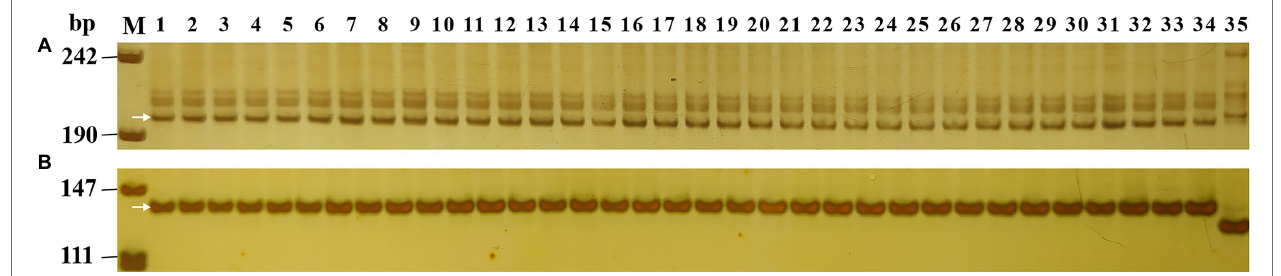
FIGURE 2 | Marker analysis of 33 Pm2 donors using Pm2 linked marker Cfd81 (A) and diagnostic marker Pm2b-map-3 (B) . Lane M, pUC18 Msp I; lane 1, Huixianhong (control without Pm2 allele); lane 2, Ulka/8*Cc (control with Pm2 allele); and lanes 3–35, the Pm2 donors identified in this